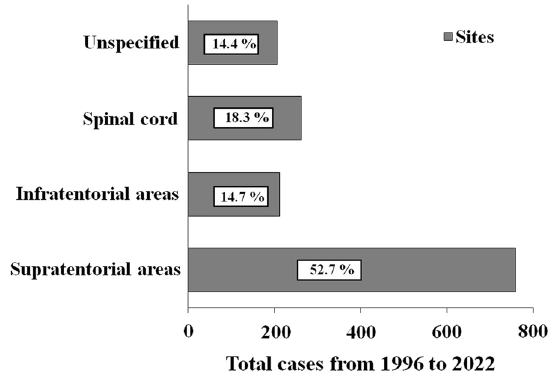
Fig. 4 Site wise distribution of CNS